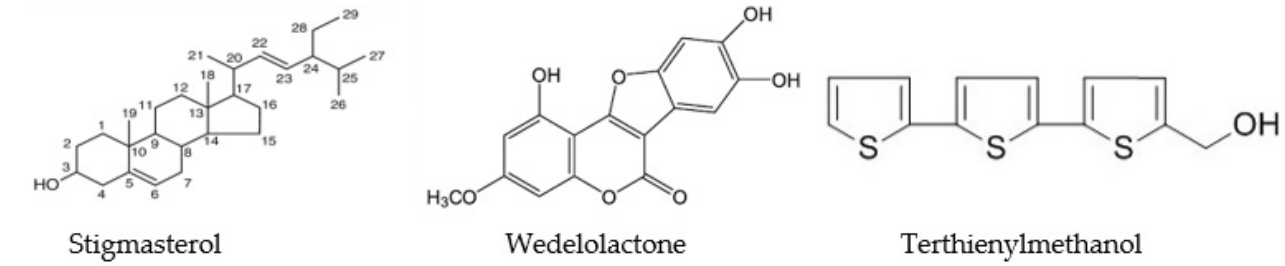
Figure 4. Chemical structure of Eclipta alba (Bhringaraj) extract bioactive compounds. 2.4. Eclipta alba (Bhringaraj) Leaf Methanolic Extract Lethality Test and Challenge